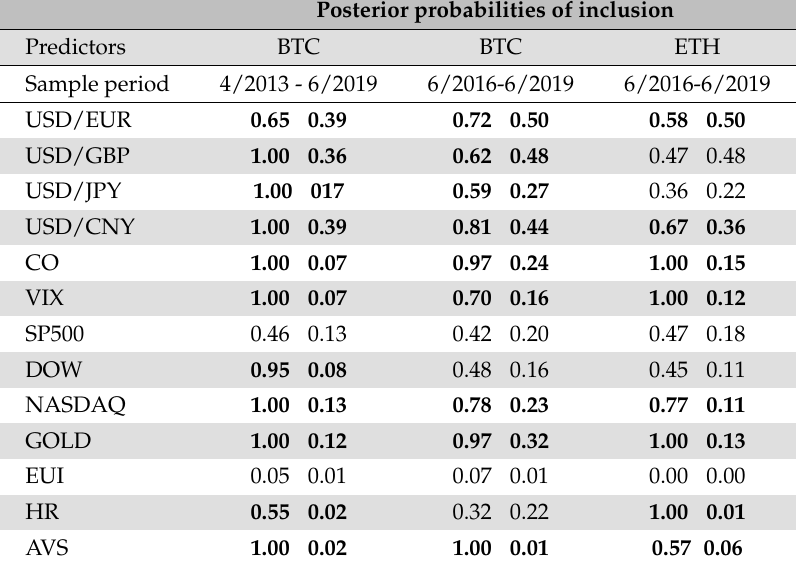
Table 3. Posterior probabilities of inclusion of the explanatory variables. The first value in each cell is the posterior probability of inclusion in the mean equation and the second the probability of inclusion in the transition probabilities of the underlying Markov process. The probabilities of the variables that are included in the median probability model, i.e., variables with probability above 0.5 in either the mean equation or the logistic regression equation are highlighted with